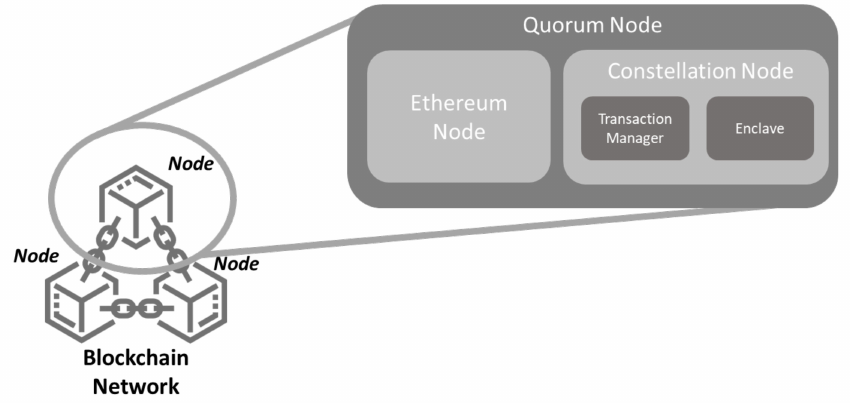
Figure 2. Quorum node